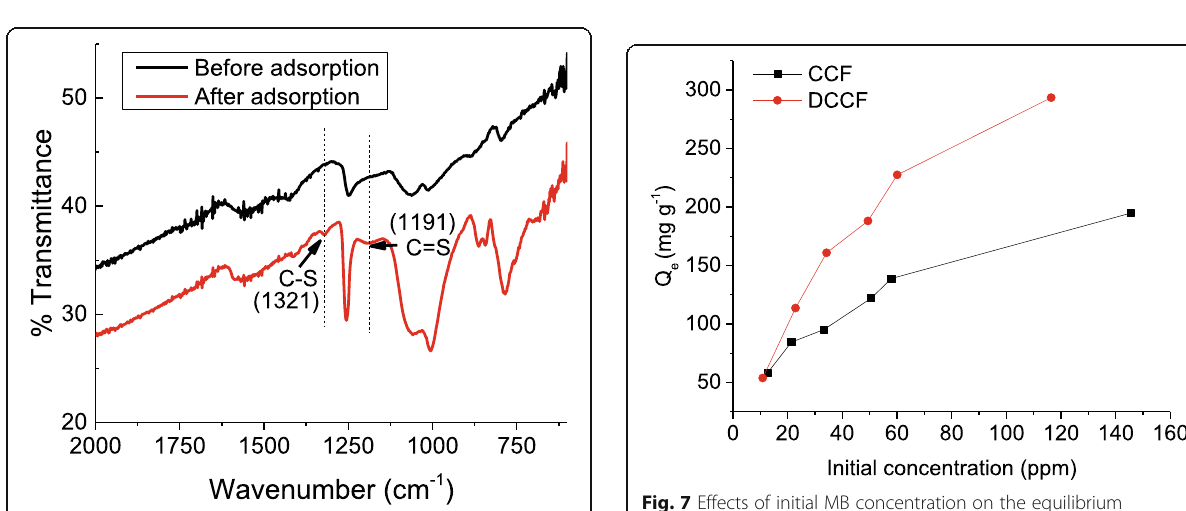
Fig. 5 FTIR of DCCF adsorbent before and after adsorption of MB